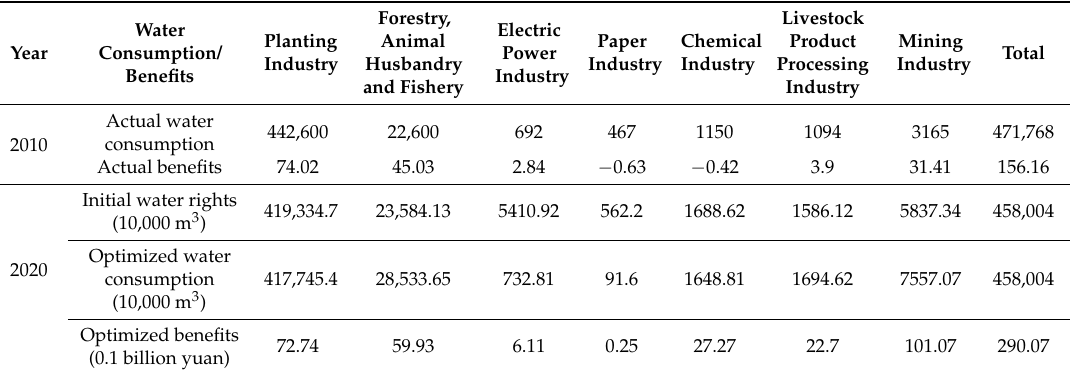
Table 6. Water consumption and benefits in 2010 and 2020.